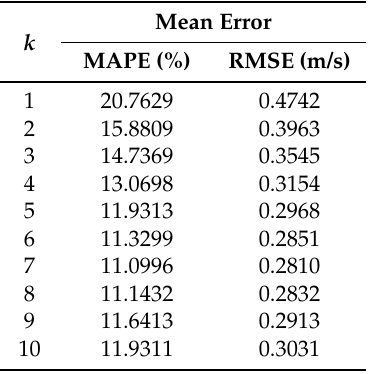
Figure 5. Decomposition results of empirical mode decomposition (EMD). The IMF sequence generated by VMD in the low-frequency area with a large amplitude had fewer fluctuations. The change trends of the data with a large amplitude, such as IMF1, IMF2, and IMF3 of VMD, were stable. For these types of data, any predictor can achieve a better prediction effect. The predictors corresponding to the IMFs with large amplitudes will have fewer forecasting errors. The IMFs in the high-frequency area with a small amplitude changed drastically. The predictors corresponding to IMFs with small amplitudes will have larger errors. However, the error of the high-frequency predictor has a limited effect on the prediction accuracy of the hybrid model